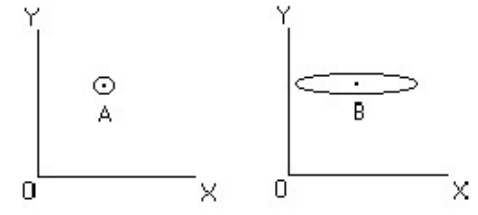
Figure 8: A simplified illustration of MacAdam ellipses. The circle (in the image on the left) and the ellipse (in the image on the right) contain all of the colour-points that cannot be distin- guished from the point in the centre, by two subjects, A and B, respectively. Subject A is able to discriminate changes in colour quite evenly in both the X and Y directions (hence a circular MacAdam “ellipse”), while subject B has poorer discrimina - tion ability in the X direction than the Y direction (hence the elongation of the ellipse in the X direction). When such ellipses are plotted on a chromaticity diagram (and not on the simplified Cartesian plane used here) the orientation of their elongation has been identified to correspond with specific colour deficiencies. Furthermore, when these ellipses elongate across the entire chro - maticity diagram, they form the sets of (directional) dichromat- confusion-lines mentioned in the